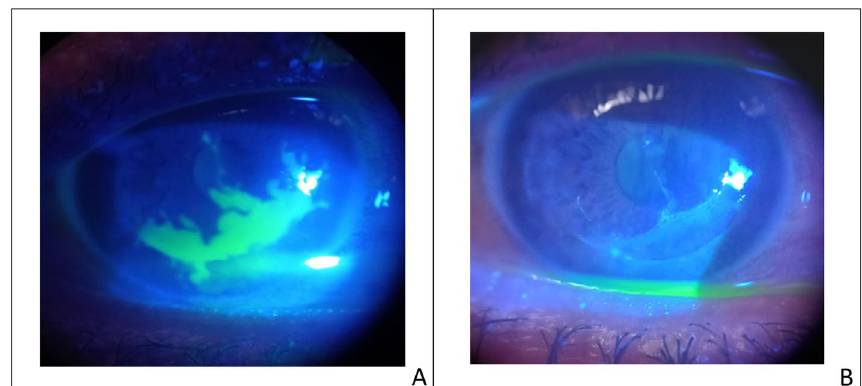
Fig. 1 A case of geographic ulcer post- LASIK surgery; pre ( A ) and post treatment ( B